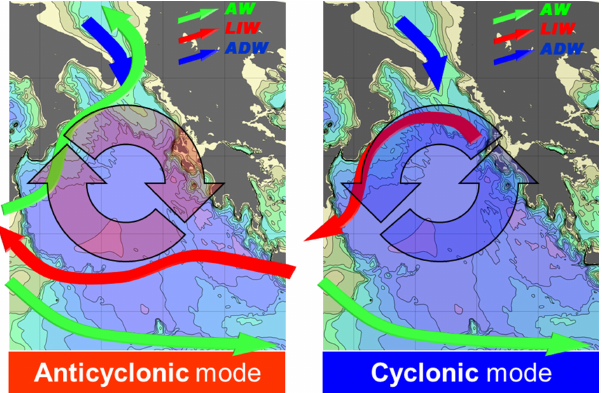
Fig. 12. Schematic presentation of the BiOS decadal inversions of the Ionian circulation and pathways of the principal water masses.